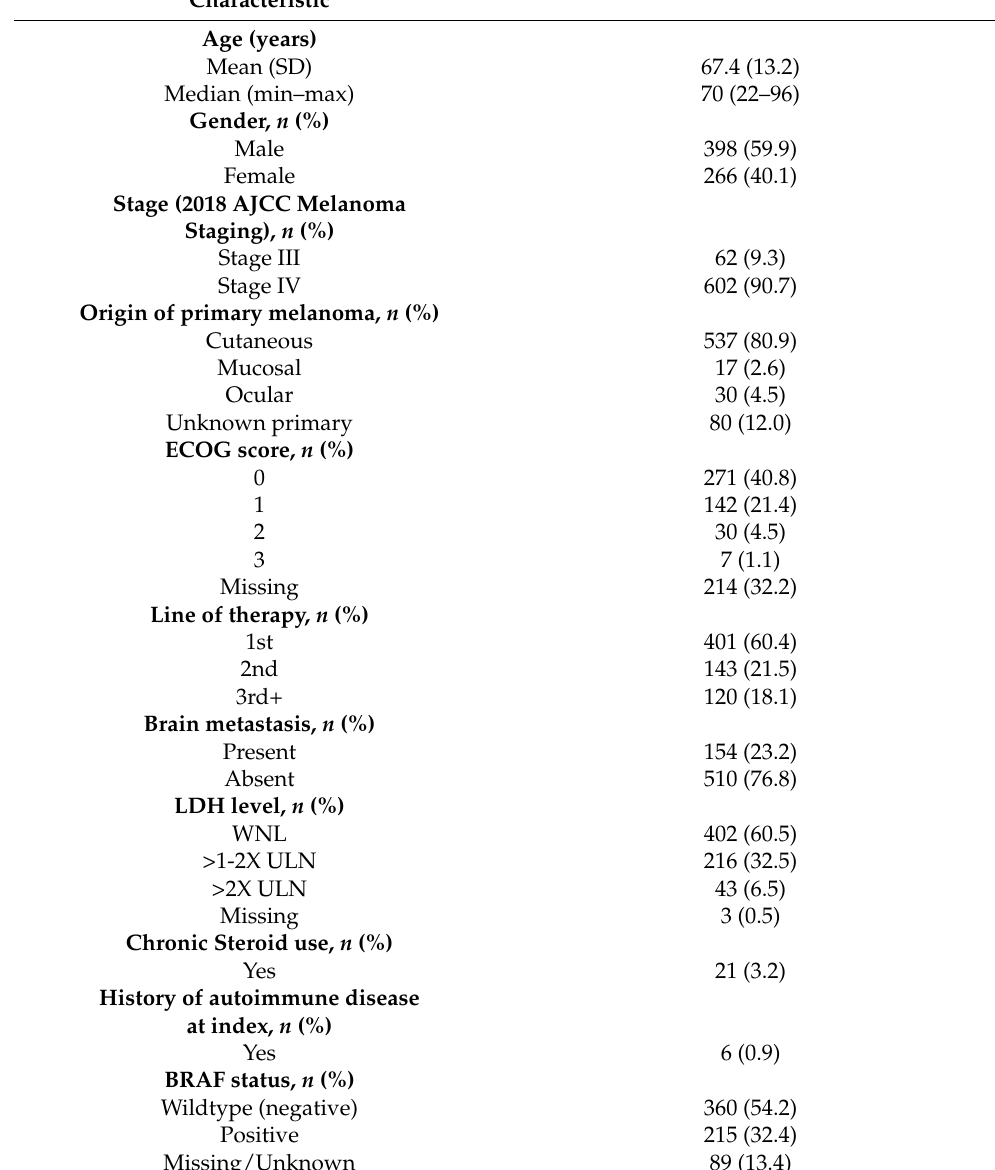
Table 2. Baseline characteristics of patients ( N = 664) at the index date (initiation of pembroli- zumab